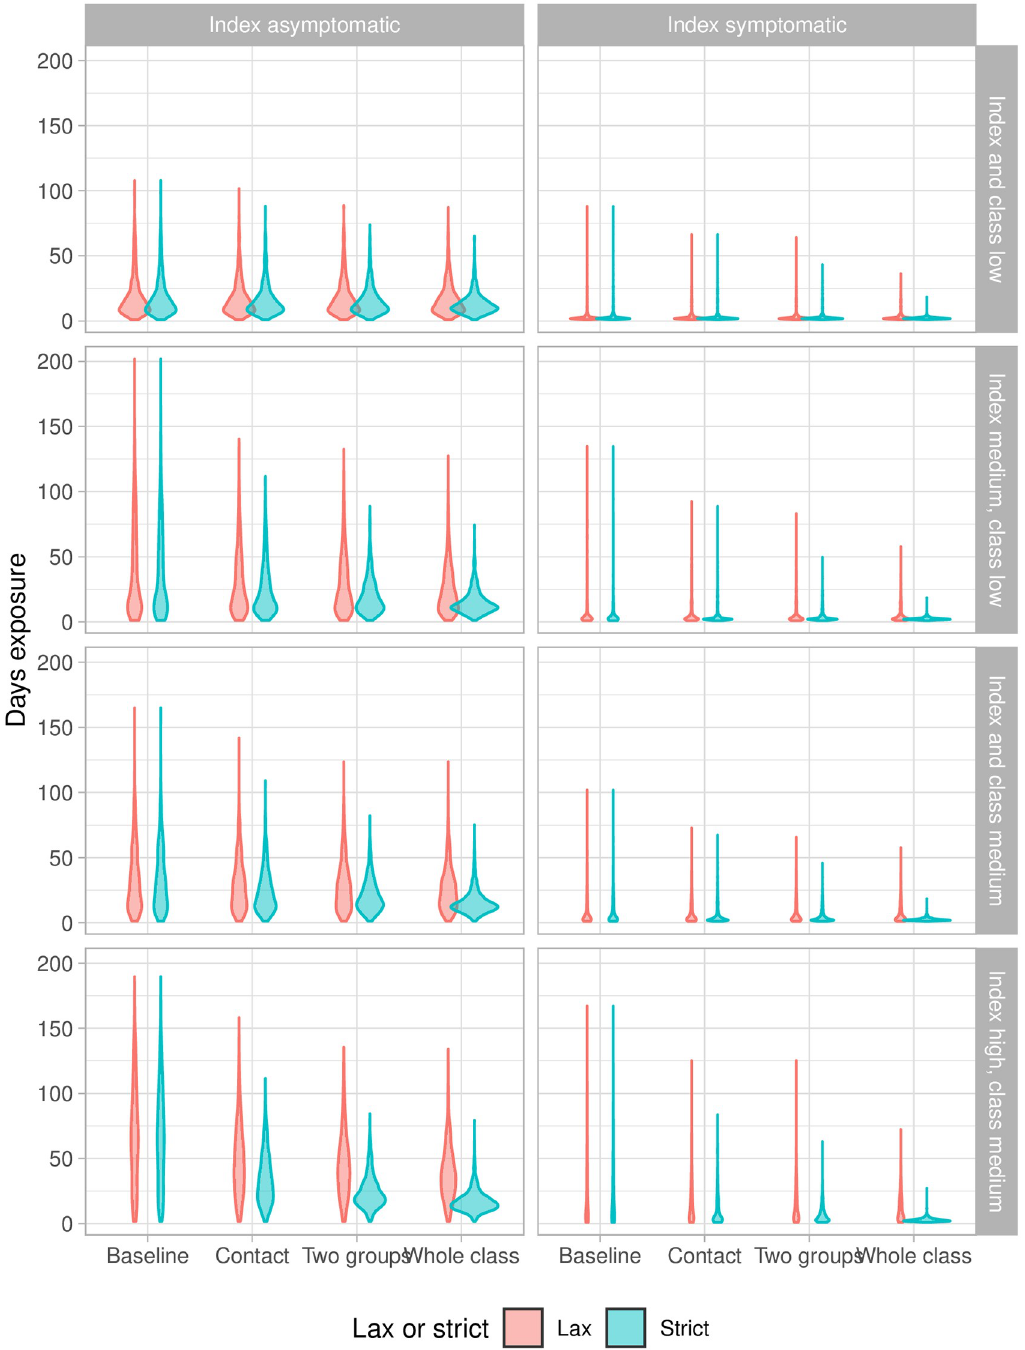
Fig 5. Asymptomatic student-days: The number of student-days on which a student is infectious but not yet told to isolate. Left: index case is asymptomatic. Right: index case is symptomatic. Lax: Only symptomatic students are ever told to isolate. Strict: All student in a shut down group or class are told to